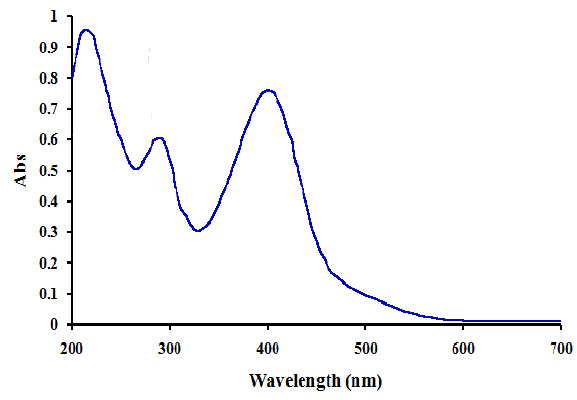
Fig. 3. Electronic spectrum of [Gd(L)